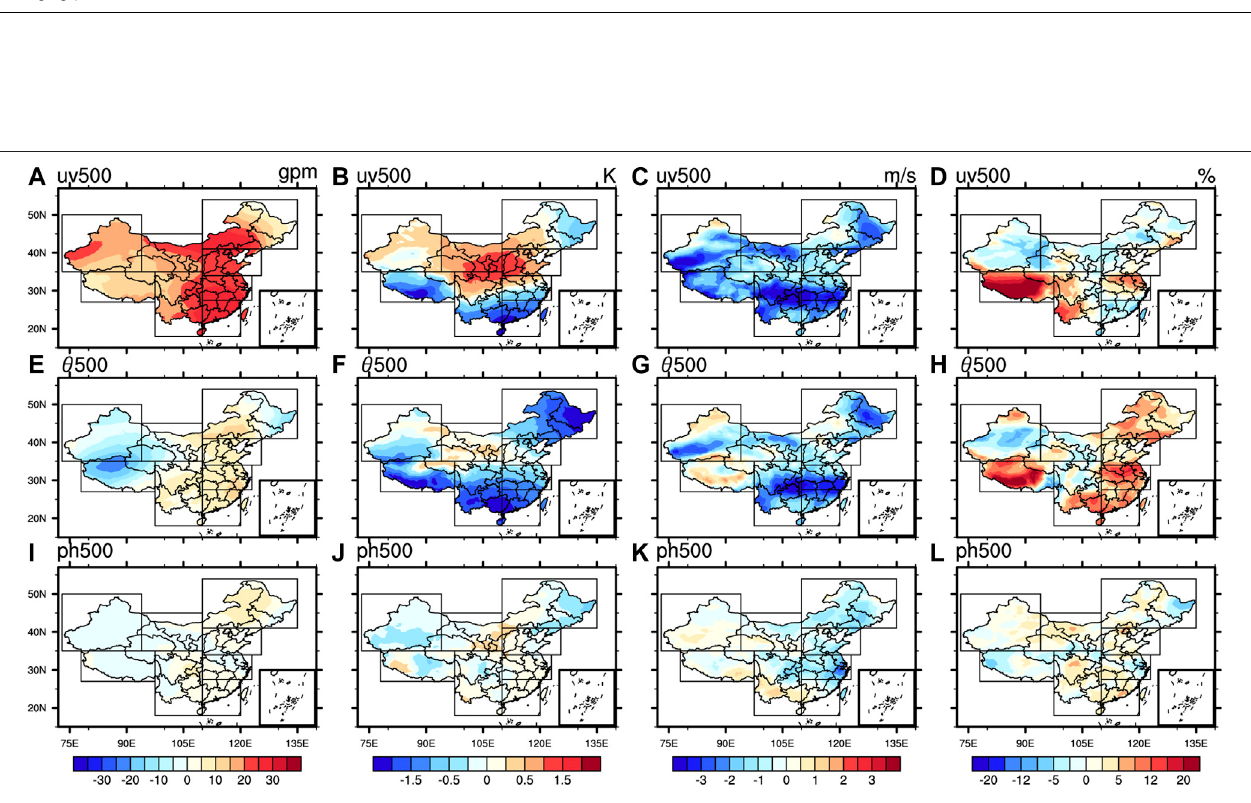
FIGURE3| SameasFIGURE2,exceptfor500 hPameteorological fi eldsincludingtheseasonalmeangeopotentialheight (A,E,I) ,temperature (B,F,J) ,windspeed (C,G,K) , and relative humidity (D,H,L) .